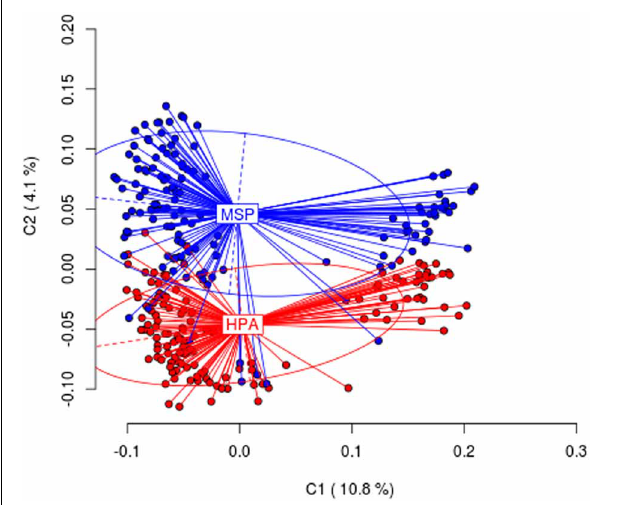
FIGURE 1 | Results from Principal Coordinates Analysis (PCoA) for the Hpa II/ Msp I comparison in all tissues analyzed. The first two coordinates (C1 and C2) are displayed with the indication of the percentage of variance explained in brackets. Scores represent individual samples. Labels indicate the centroids of each group. Ellipses represent the dispersion associated to each value. The long axis of the ellipse shows the direction of maximum dispersion and the short axis shows the direction of minimum